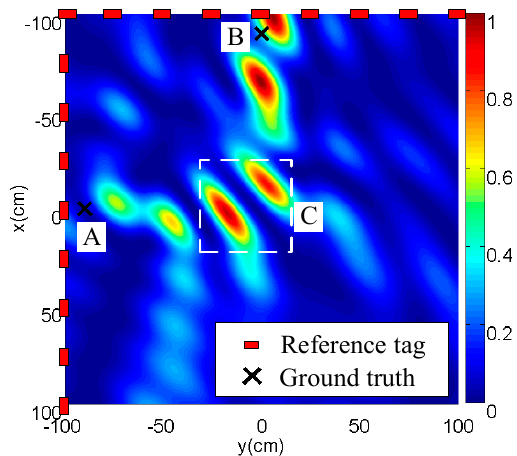
Figure 2. The preliminary 2-D spatial spectrum.